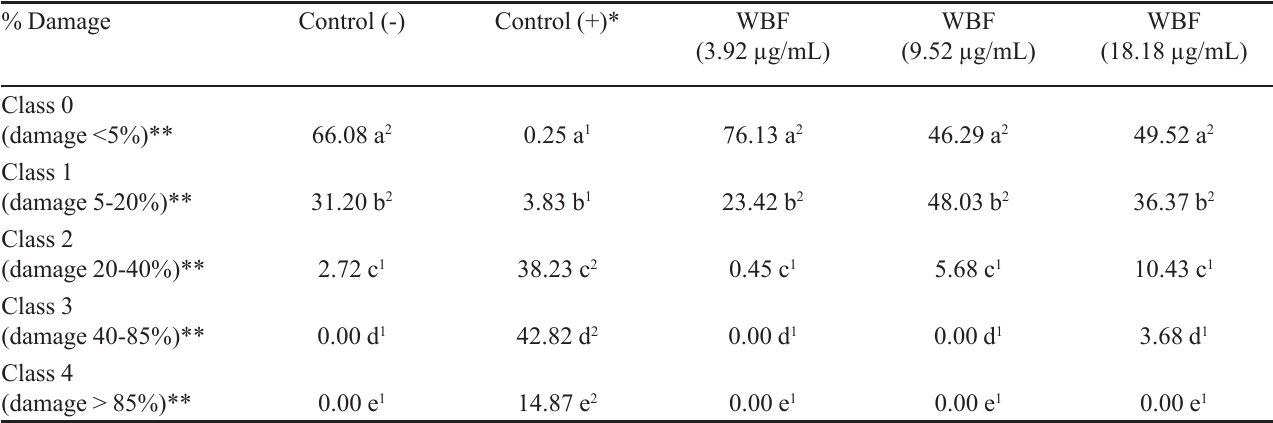
TABLE I - Average number of cells per comet class after treatment with different concentrations of aqueous solution of white bean flour